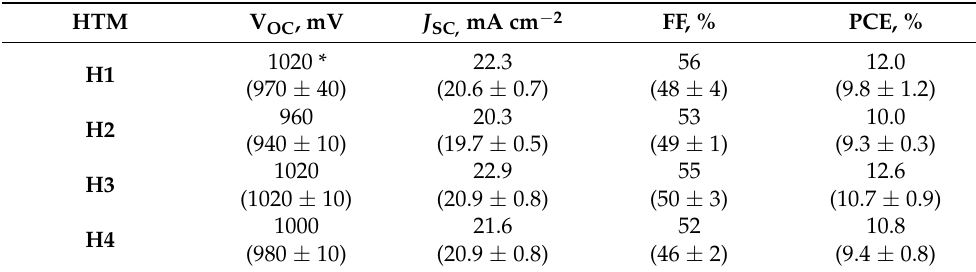
Table 1. Photovoltaic performance of PSCs based on H1 - 4.